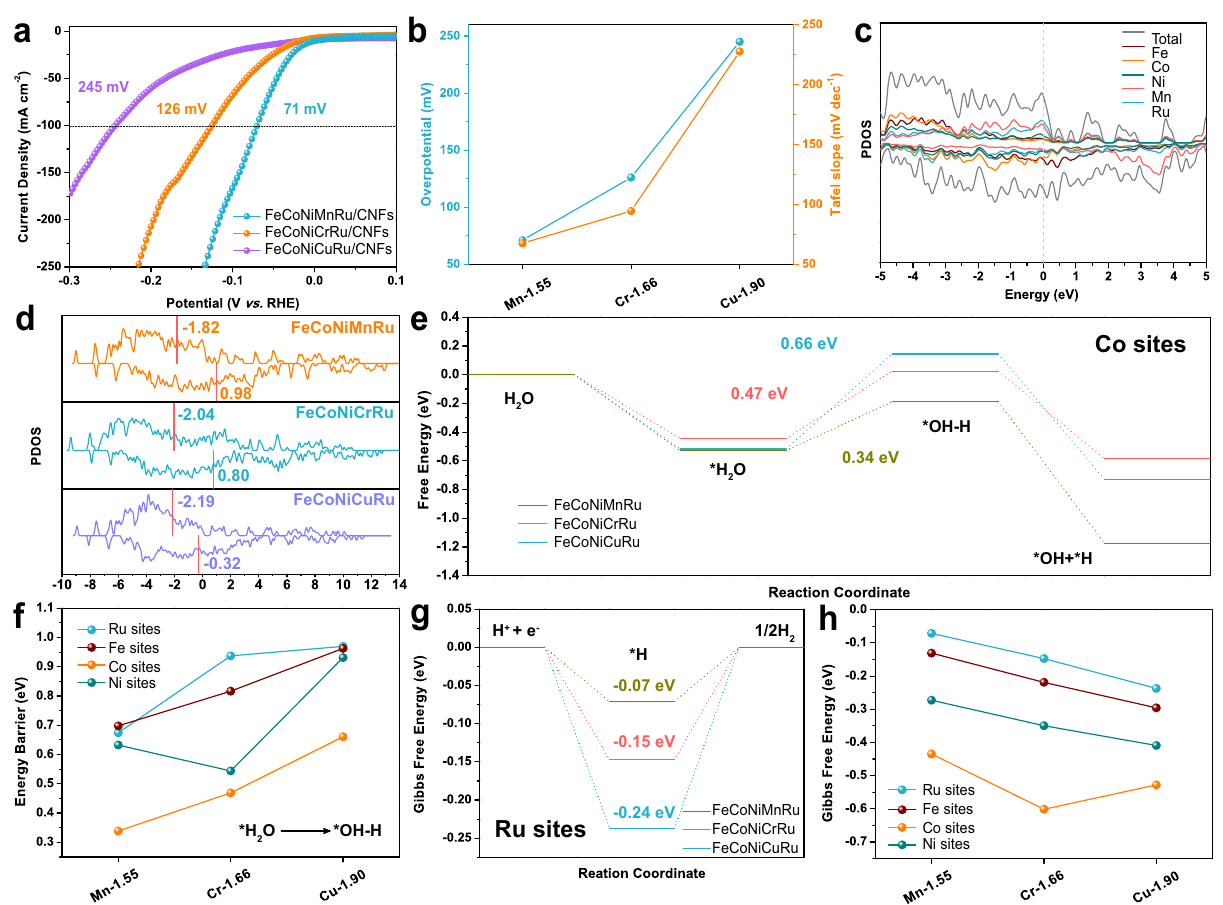
Fig. 7 Relationship between metal electronegativity and electrochemical performance. a HER polarization curves obtained on FeCoNiXRu/CNFs (X = Cr, Mn, and Cu) in 1.0 M KOH electrolyte. b Correlation between the HER overpotentials at 100 mA cm − 2 , Tafel slopes, and the electronegativities of metals X (Cr, Mn, and Cu). c The d-orbital projected density of states (PDOS) of Fe, Co, Ni, Mn, Ru, and FeCoNiMnRu. d Comparison of PDOS of FeCoNiXRu (X = Mn, Cr, Cu) HEA. e Reaction energy pro fi le for water dissociation at Co sites of FeCoNiMnRu, FeCoNiCrRu, and FeCoNiCuRu HEA surfaces. f Correlation between the energy barrier for H 2 O dissociation at different metal sites and the electronegativities of metals (Cr, Mn, and Cu). g Gibbs free energy ( Δ G H* ) pro fi les at Ru sites on the FeCoNiMnRu, FeCoNiCrRu, and FeCoNiCuRu HEA surfaces. h Correlation between Δ G H* at different metal sites and the electronegativities of metals X (Cr, Mn, and